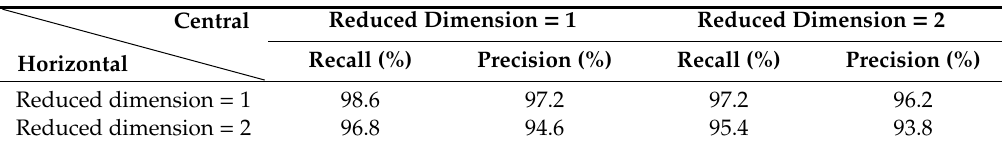
Table 6. Central and vertical reduction results.